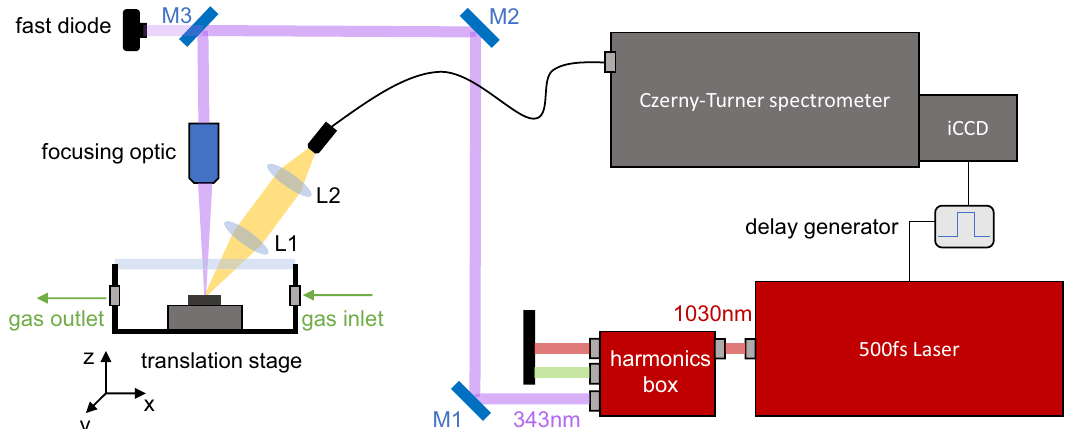
Figure 6. Experimental Setup of femtosecond UV LIBS experiment including the laser system, harmonic generation box, a set of mirrors (M1-M3), the focusing optic, a translation stage with the sample inside of a chamber with a gas in- and outlet, and the collection system with two lenses (L1 and L2) and a Czerny-Turner spectrometer with iCCD